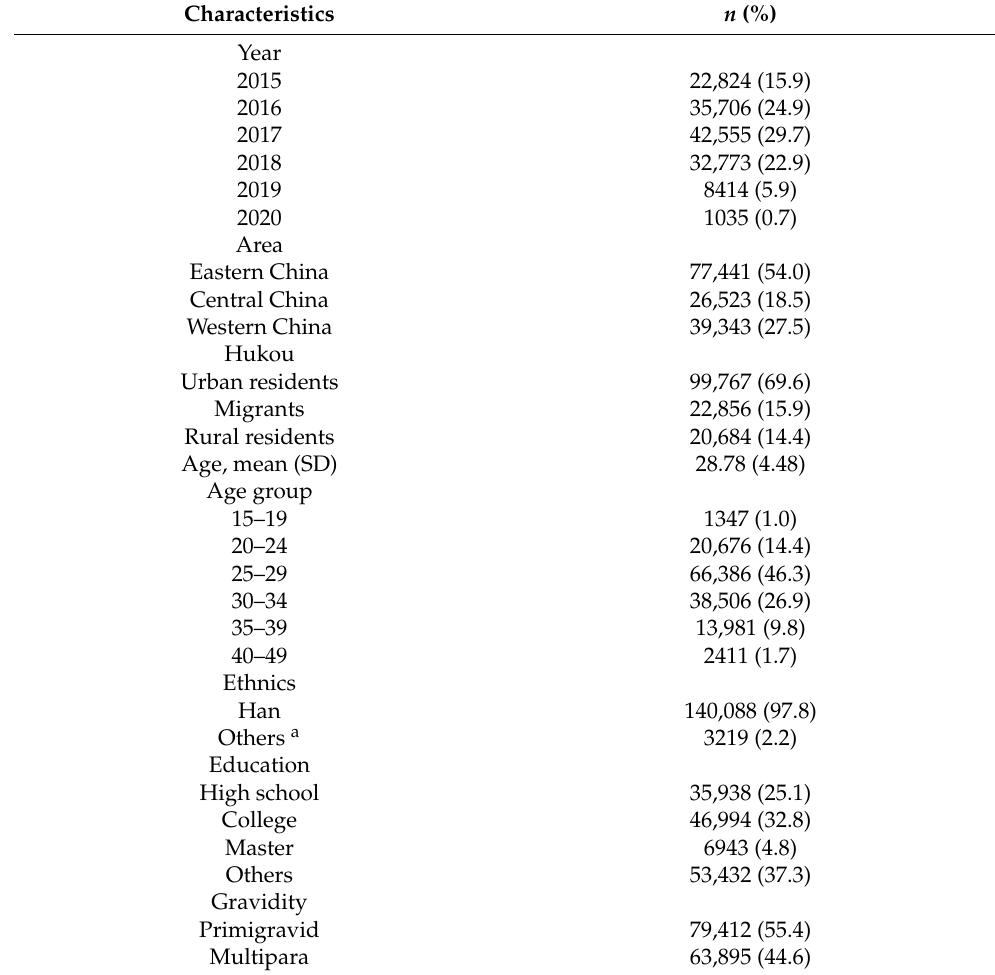
Table 1. Basic characteristics of pregnant women.